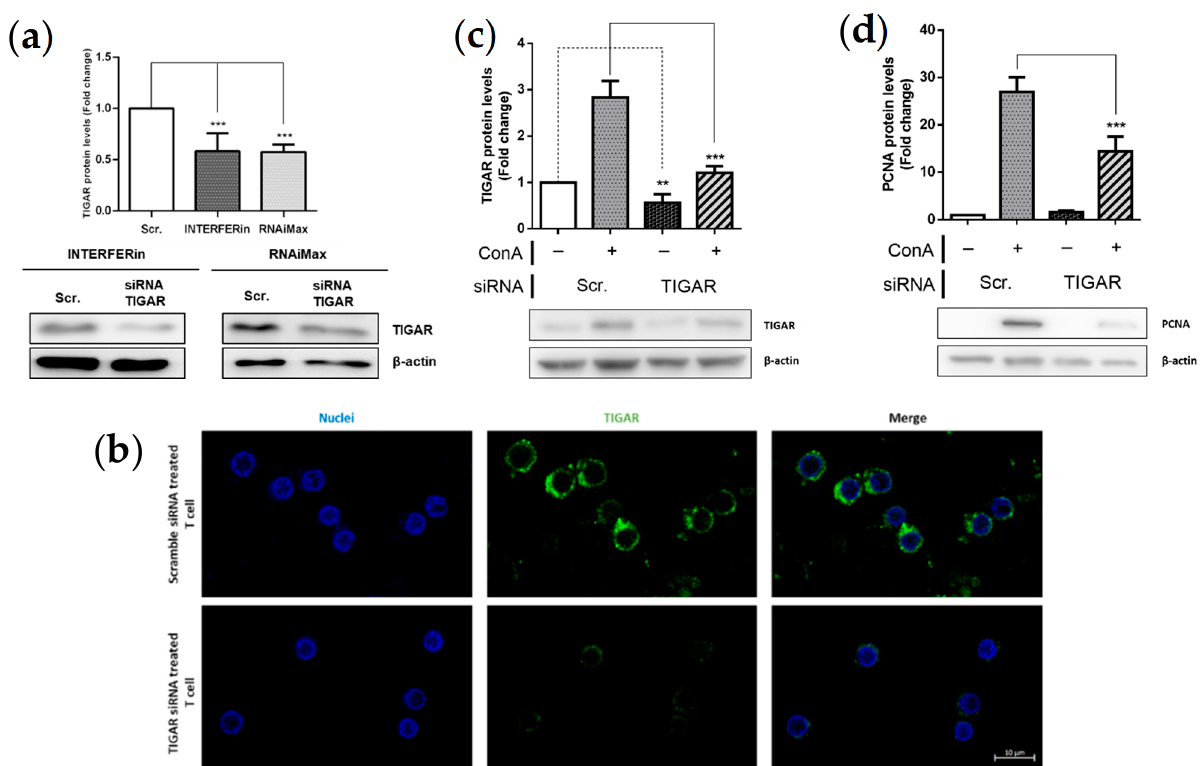
Figure 3. TIGAR silencing in ConA-stimulated lymphocytes. ( a ) Western Blot analysis and quantification of TIGAR silenced lymphocytes with two different reagents (INTERFERin and RNAiMax) for 48 h. Representative Western blot image is shown. ( b ) Images of immunofluorescence analysis of silenced TIGAR lymphocytes with INTERFERin reagent. ( c ) Western blot analysis and quantification of silenced TIGAR lymphocytes in response to 10 µg/mL ConA (48 h). Representative Western blot images are shown ( d ) Western blot analysis and quantification of PCNA in silenced TIGAR lymphocytes in response to 10 µg/mL ConA (48 h). Representative Western blot image is shown. Quantification of each protein level was normalized to β -actin levels. All data are presented as a mean fold change relative to untreated cells ± SEM. Differences were calculated with two-way ANOVA and Tukey’s multiple comparisons test with a normal-based 95% CI. Significant p values are indicated; ** p < 0.01 *** p < 0.001; n = 3.